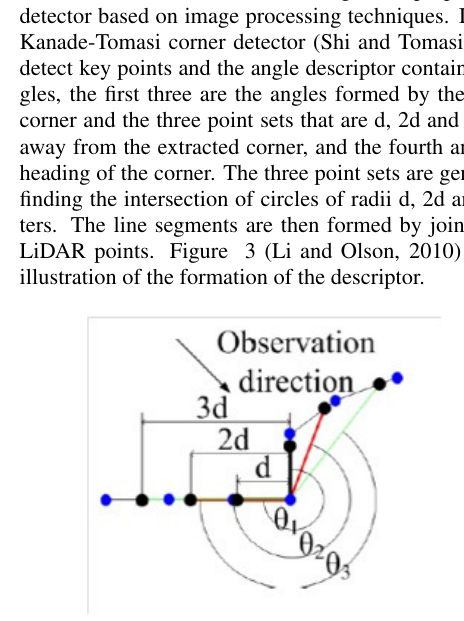
Figure 3: Li & Olson descriptor